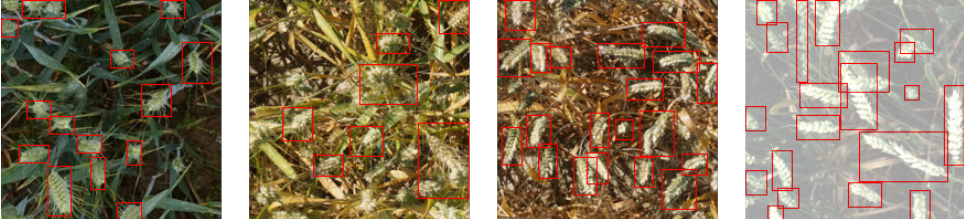
Figure 11. Validation results of our model for small-scale object feature extraction capability on wheat ears dataset. Red boxes: the detected wheat